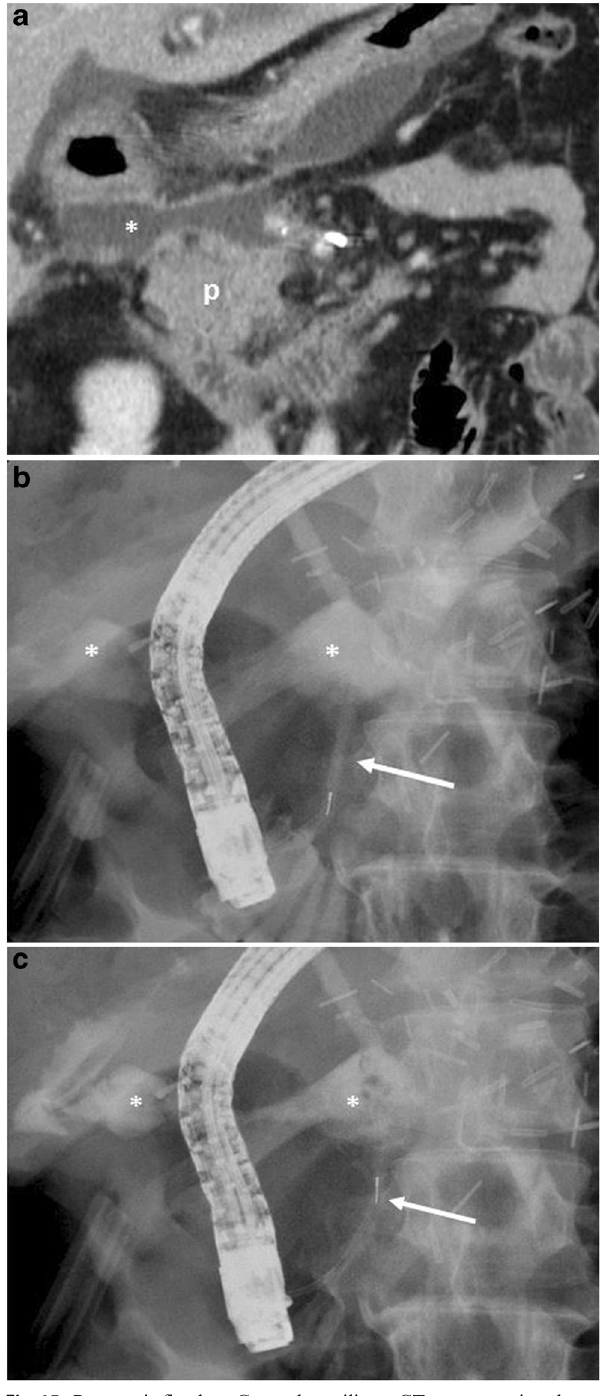
Fig. 15 Pancreatic fistula. a Coronal curvilinear CTreconstruction shows the presence of a fluid collection (*) close to the resection margin of the pancreas (p) after a distal pancreatectomy. The presence of amylase from a surgical drainage (not shown in a ) was consistent with a pancreatic fistula. b , c Spot images during ERCP show the passage of contrast material through the main pancreatic duct (white arrows) in the collection (*), a finding diagnostic for a leakage of pancreatic juice at the resection margin